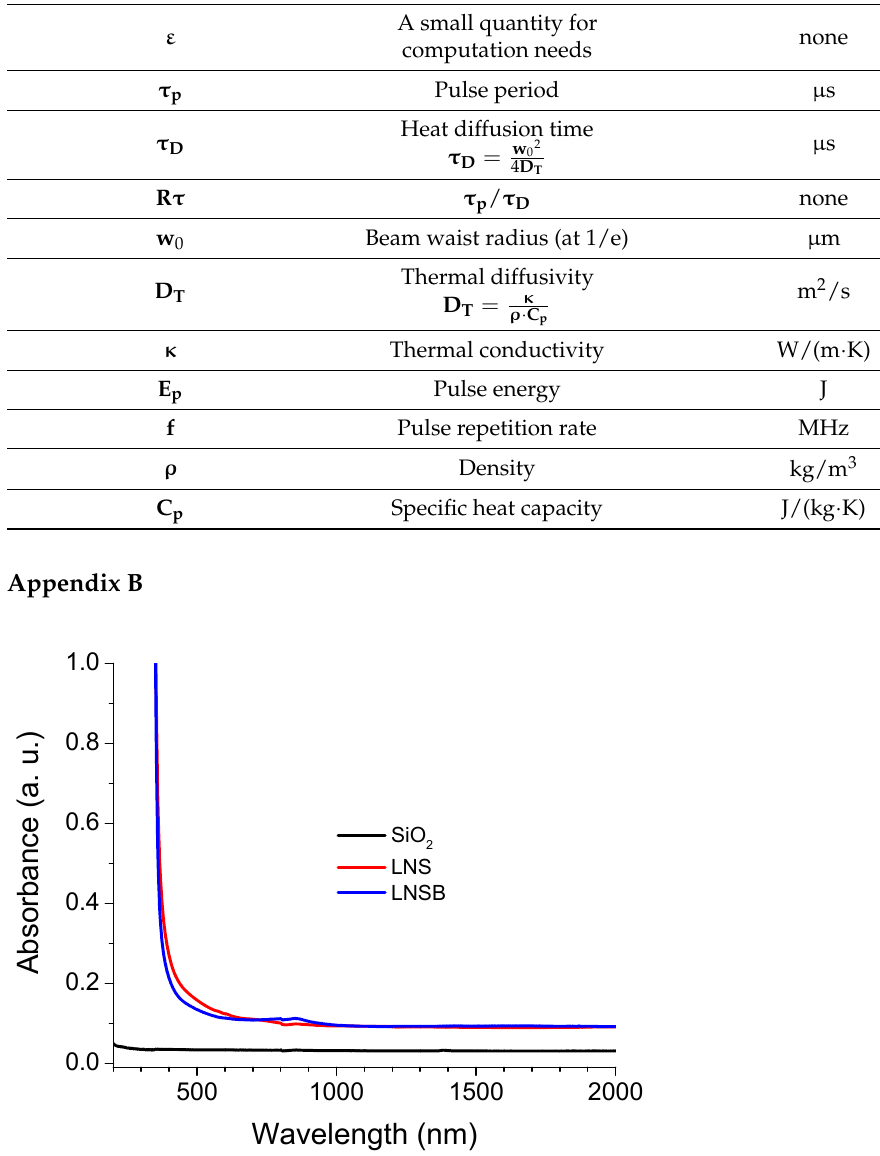
Figure A1. Absorption spectra for LNS, LNSB, with SiO 2 (Suprasil) added as a reference. The data were taken using a Cary5000 spectrophotometer. There is no specific absorption band situated at 1030 nm that could cause a drastic multiphoton absorption difference between the two silicate glasses.